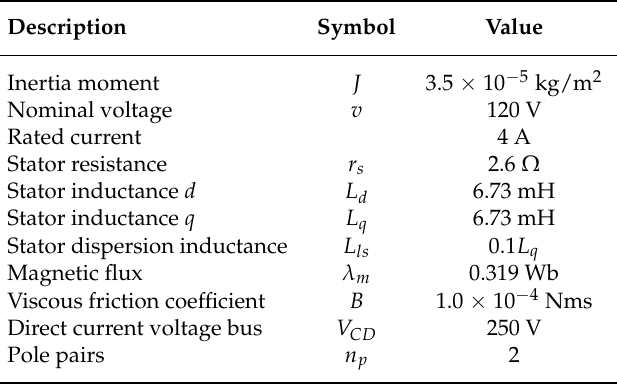
Table 1. PMSM nominal parameters.